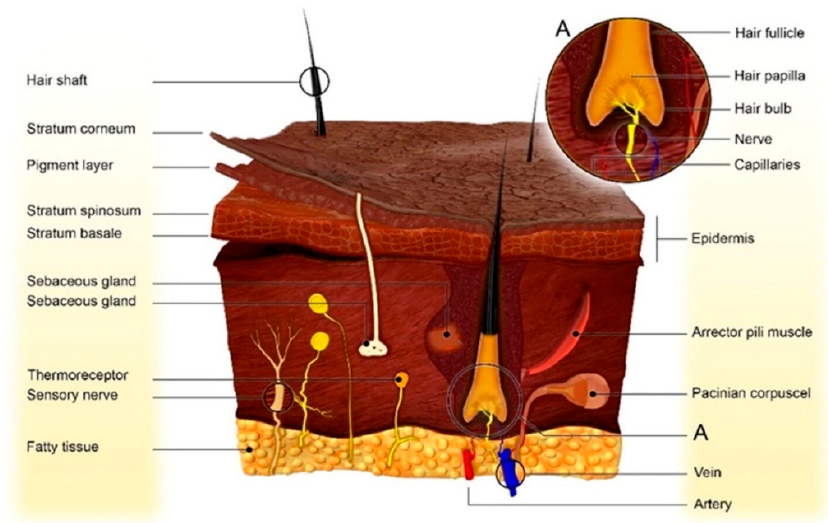
Figure 2. Anatomical structure of skin (reproduced with permission from [67], copyright 2019 Elsevier B.V.)